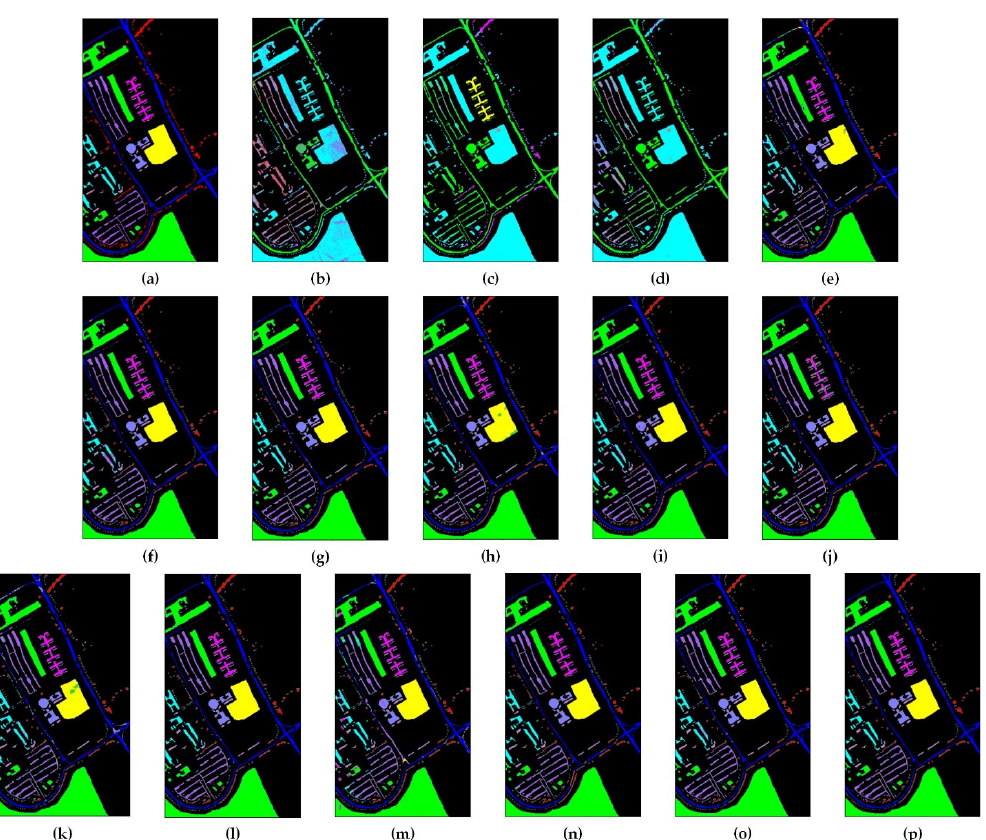
Figure 16. Classification maps on the UP dataset. ( a ) Ground truth. ( b ) SVM. ( c ) RF. ( d ) MLR. ( e ) 1D_CNN. ( f ) 2D_CNN. ( g ) 3D_CNN. ( h ) 2D_3D_CNN. ( i ) RSANN. ( j ) SSAN. ( k ) MAFN. ( l ) DCRN.